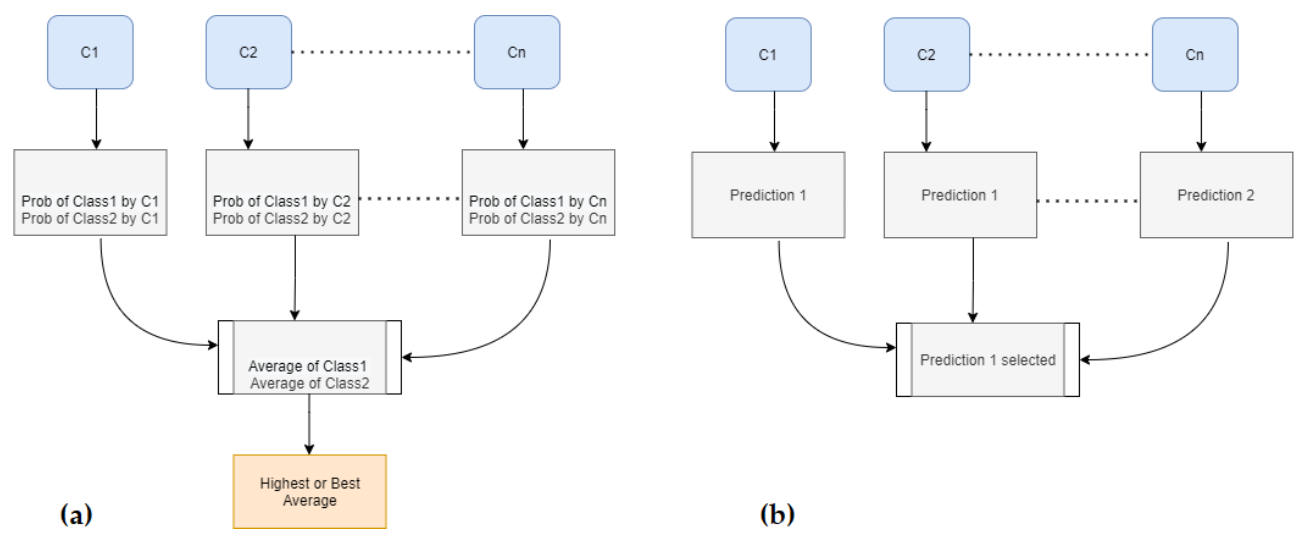
Figure 4. Ensemble phenomena: ( a ) soft voting, ( b ) hard voting.